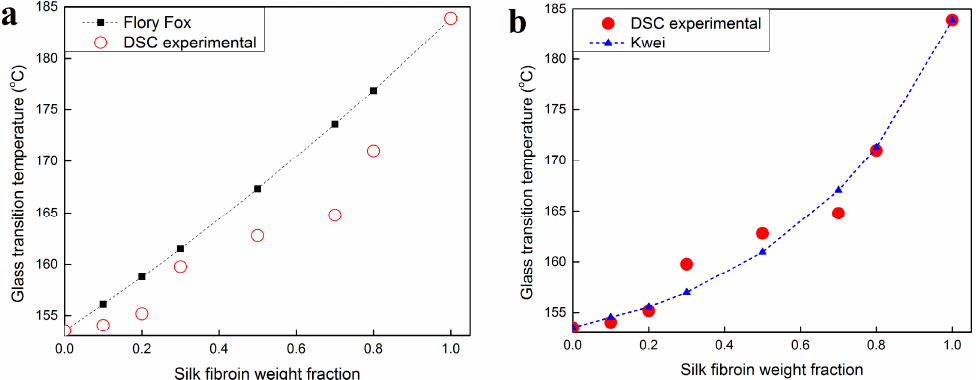
Figure 5. ( a ) Comparison between theoretical glass transition temperatures calculated using the Flory–Fox equation and the experimental glass transition temperatures collected using TM-DSC results; ( b ) comparison between theoretical glass transition temperatures calculated using Kwei equation (with k = 2.6 and q = − 4) and the experimental glass transition temperatures collected using TM-DSC